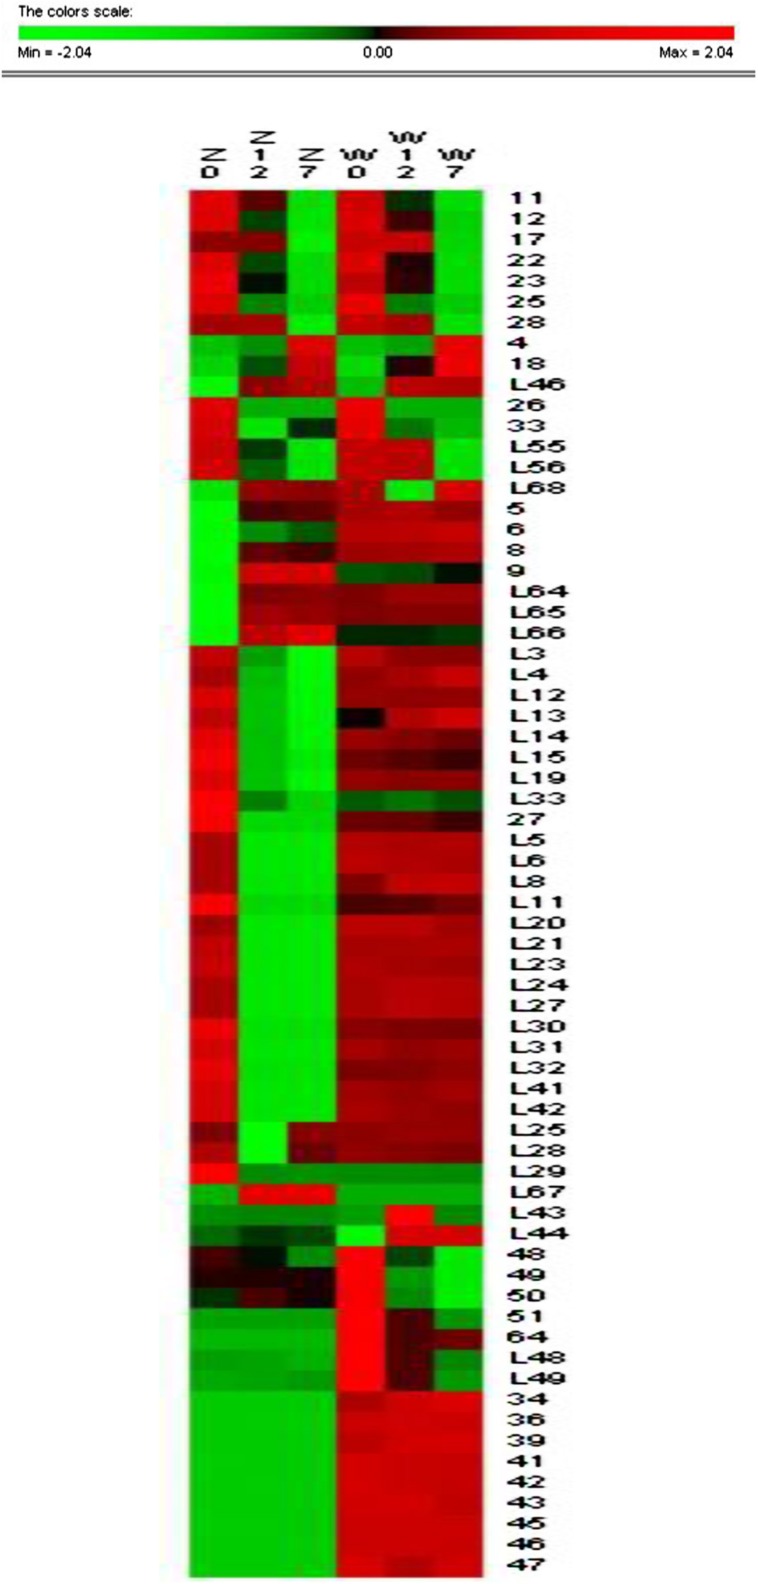
Cluster analysis of 67 identified spots. Cluster analysis reveals changes of the relative abundance of identified protein by software PermutMatrix v1.9. Normalized rows (Z scores) and Ward’s algorithm have been used to analyze data. In the figure, ZC is control of ZD, Z12 is treatment of ZD at 4°C for 12 h, Z7 is treatment of ZD at 4°C for 7 days, WC is control of W5, W12 is treatment of W5 at 4°C for 12 h, and W7 is treatment of W5 at 4°C for 7 days. Digits in the figure represent spots No.